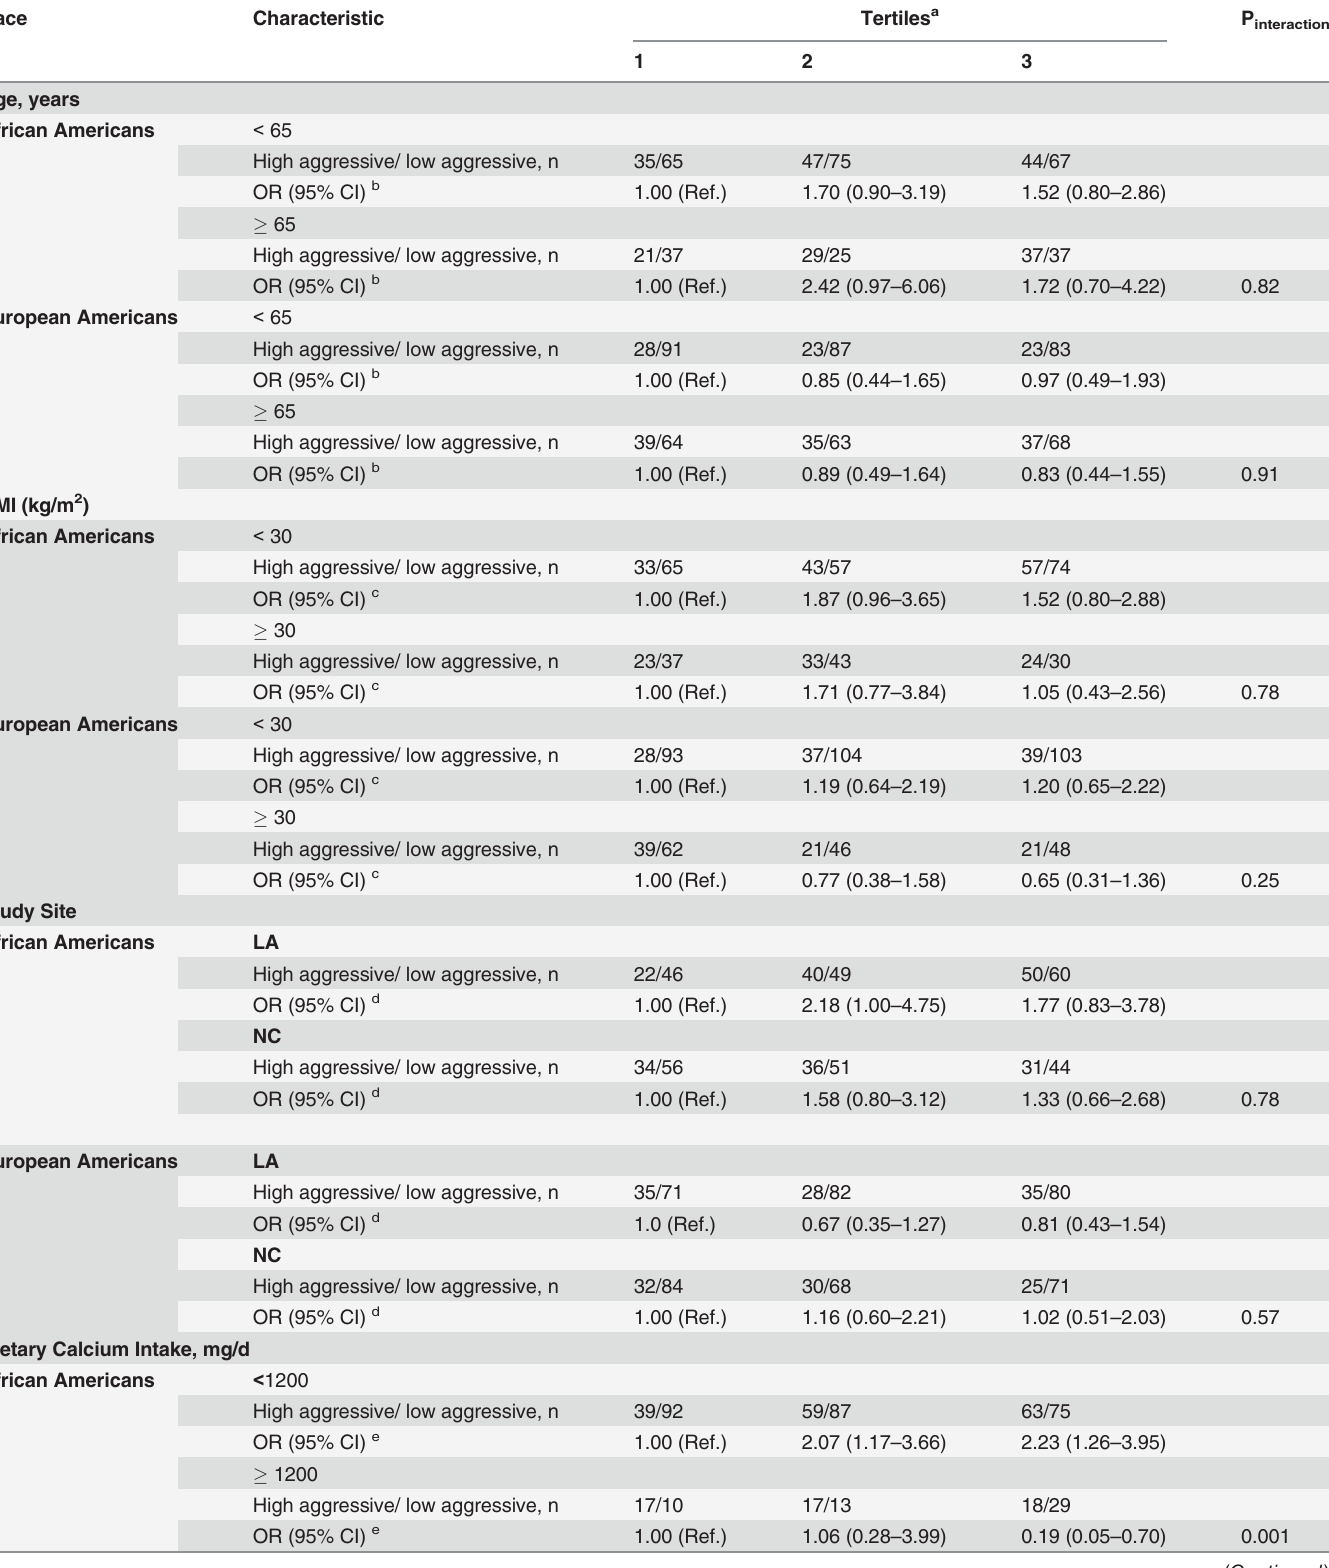
Table 3. Association between measured concentrations of plasma 25(OH)D3 and prostate cancer aggressiveness stratified by race and selected demographic, clinical and dietary characteristics.